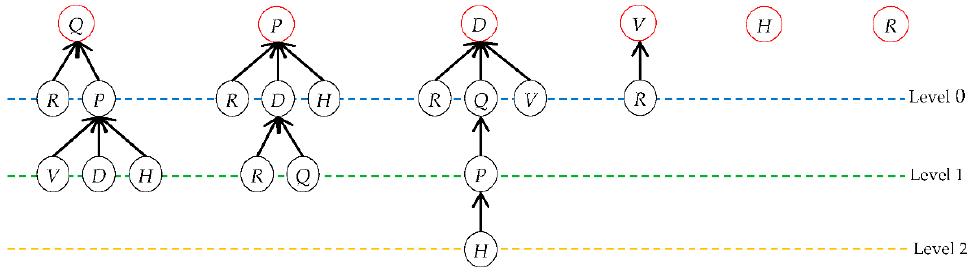
Figure 9. Subordinate trees for dummy data.